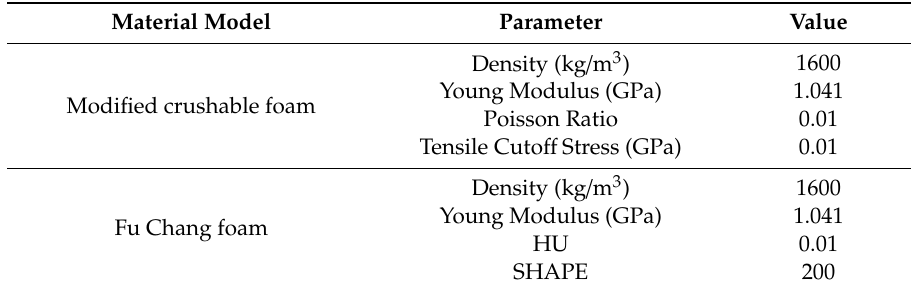
Table 5. Input parameter for modified crushable foam and Fu Chang foam material model in LS-DYNA.